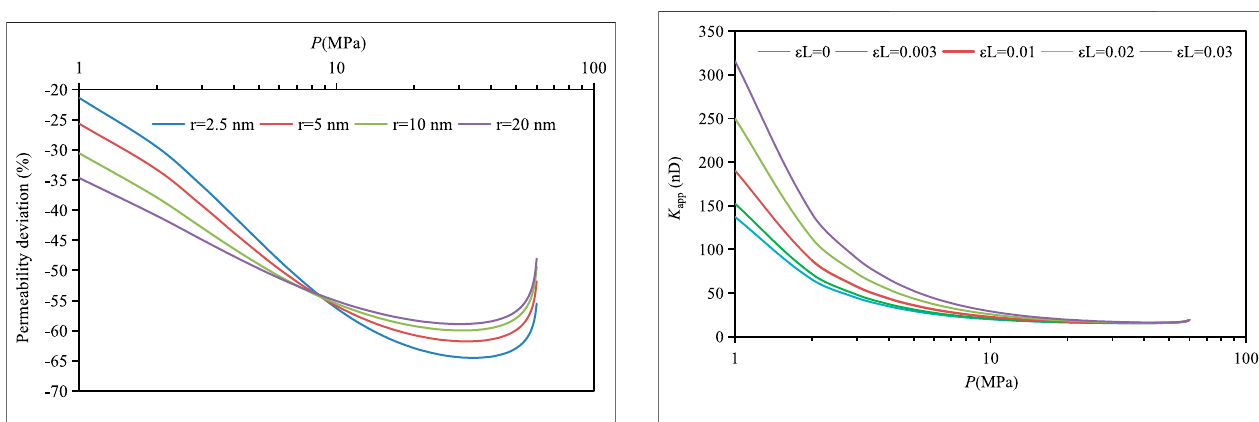
FIGURE 5 | Effect of the Langmuir strain on the apparent permeability.